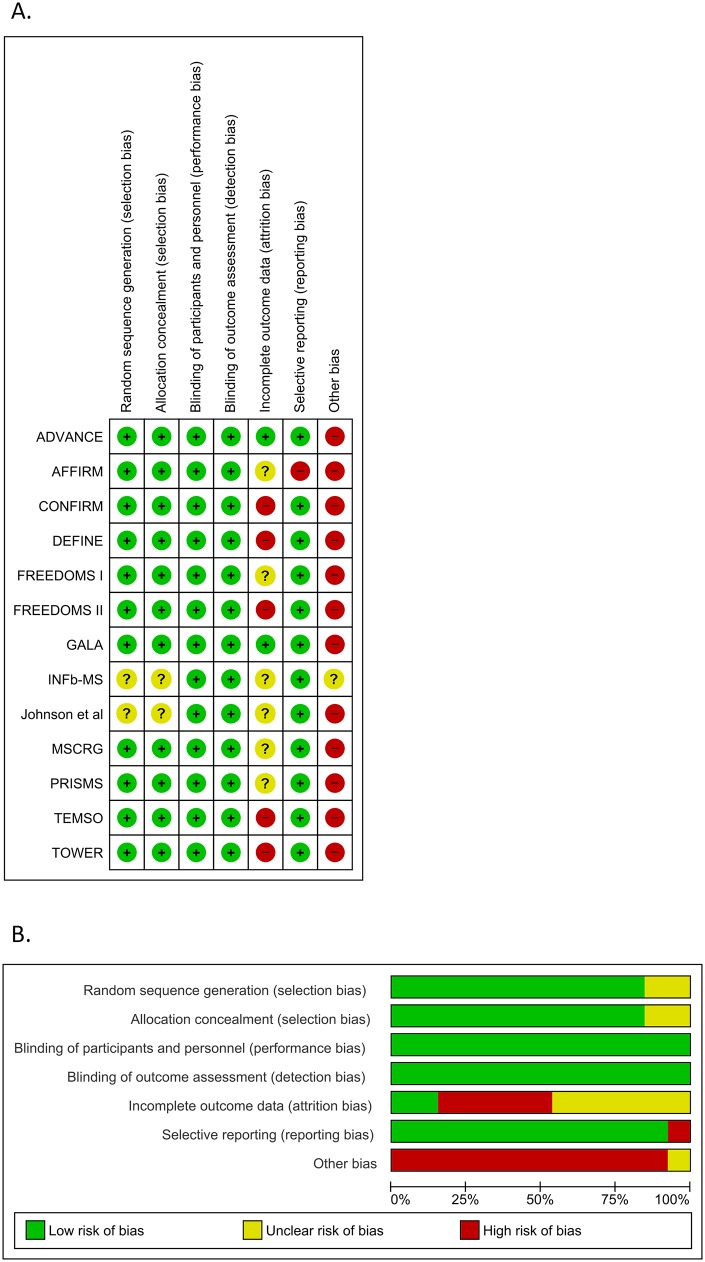

A) Risk of bias summary. Review authors' judgments about each risk of bias item for each included study. B) Risk of bias graph. Review authors' judgments about each risk of bias item presented as percentages across all included studies.